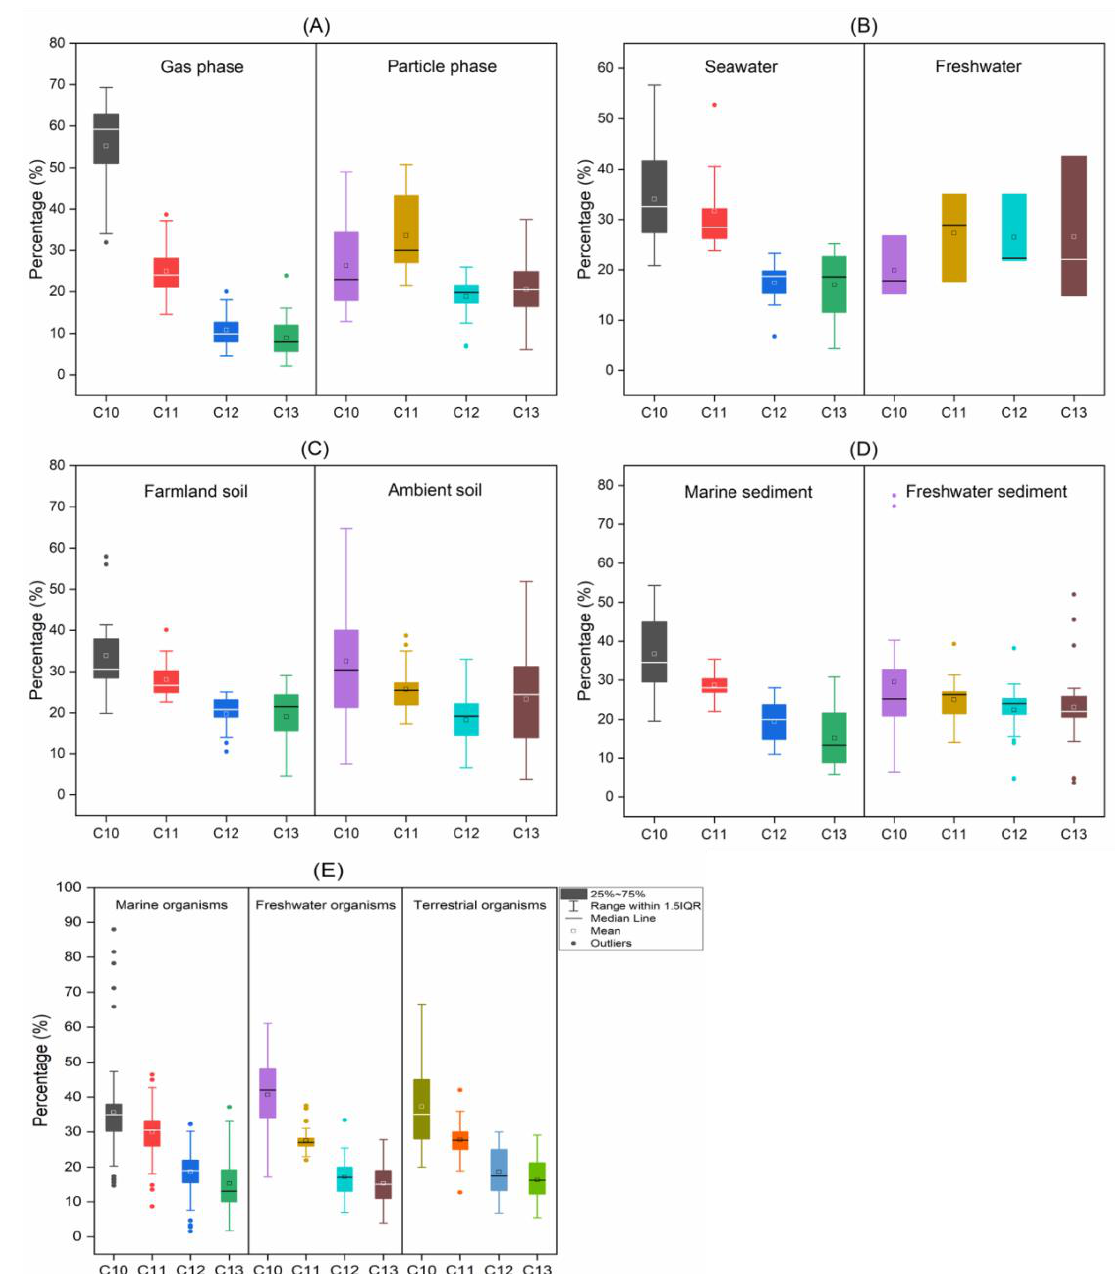
Figure 3. Carbon profiles of SCCPs in different environmental matrices in China. ( A ) Carbon profiles of SCCPs in air. ( B ) Carbon profiles of SCCPs in water. ( C ) Carbon profiles of SCCPs in soil. ( D ) Carbon profiles of SCCPs in sediment. ( E ) Carbon profiles of SCCPs in biota.